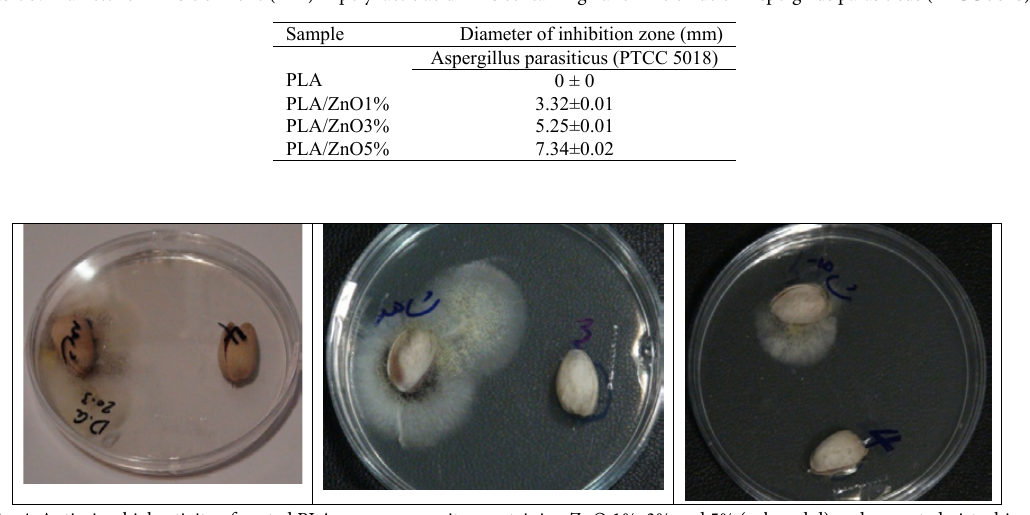
Table 3. Diameter of inhibition zone (mm) in poly lactic acid films containing nano-zinc oxide on Aspergillus parasiticus (PTCC 5018)